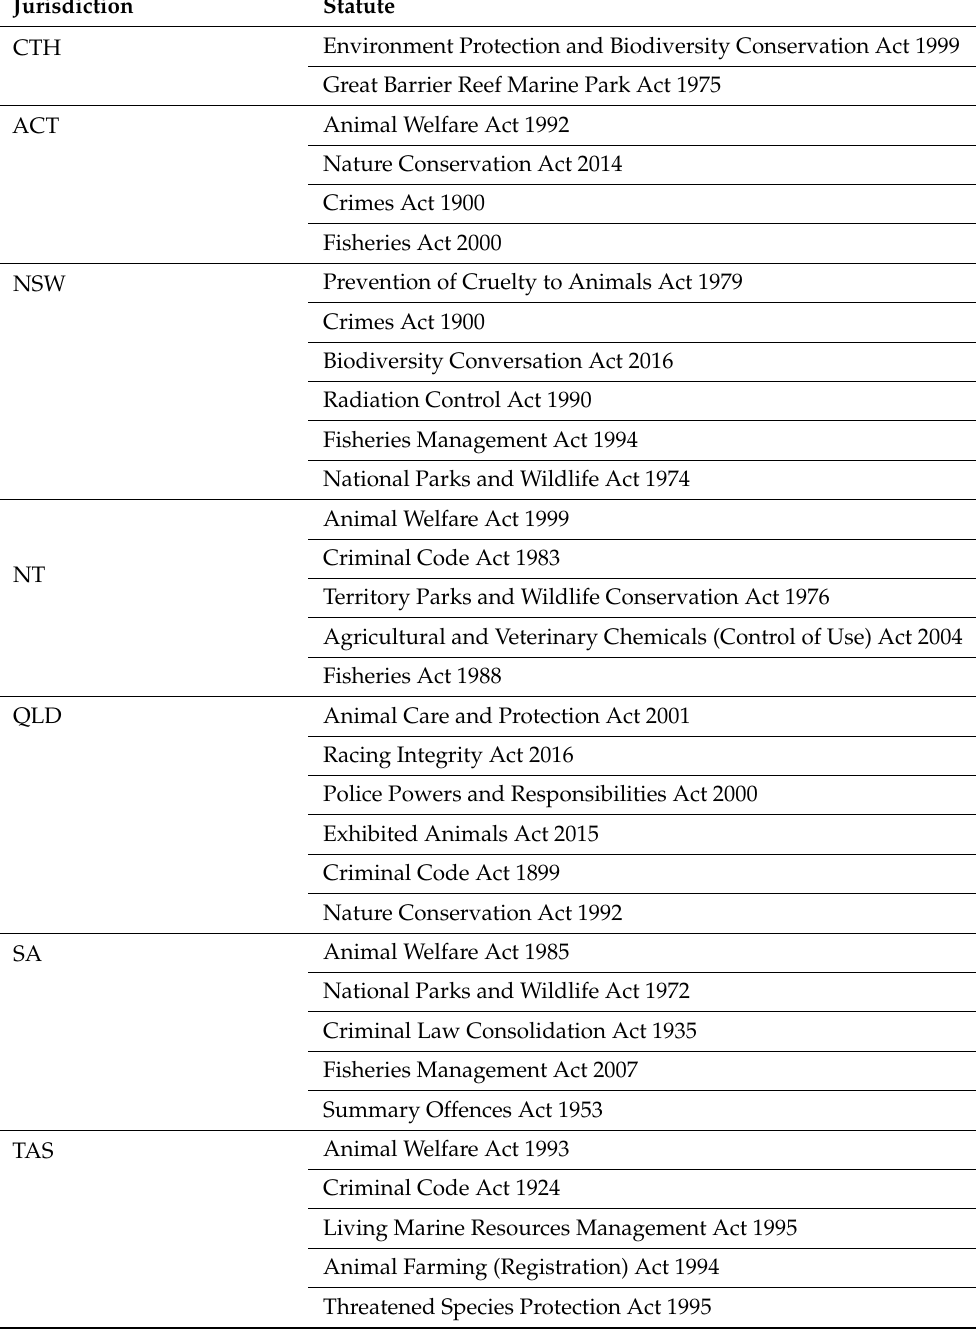
Table A1. Statutes with animal welfare provisions included for